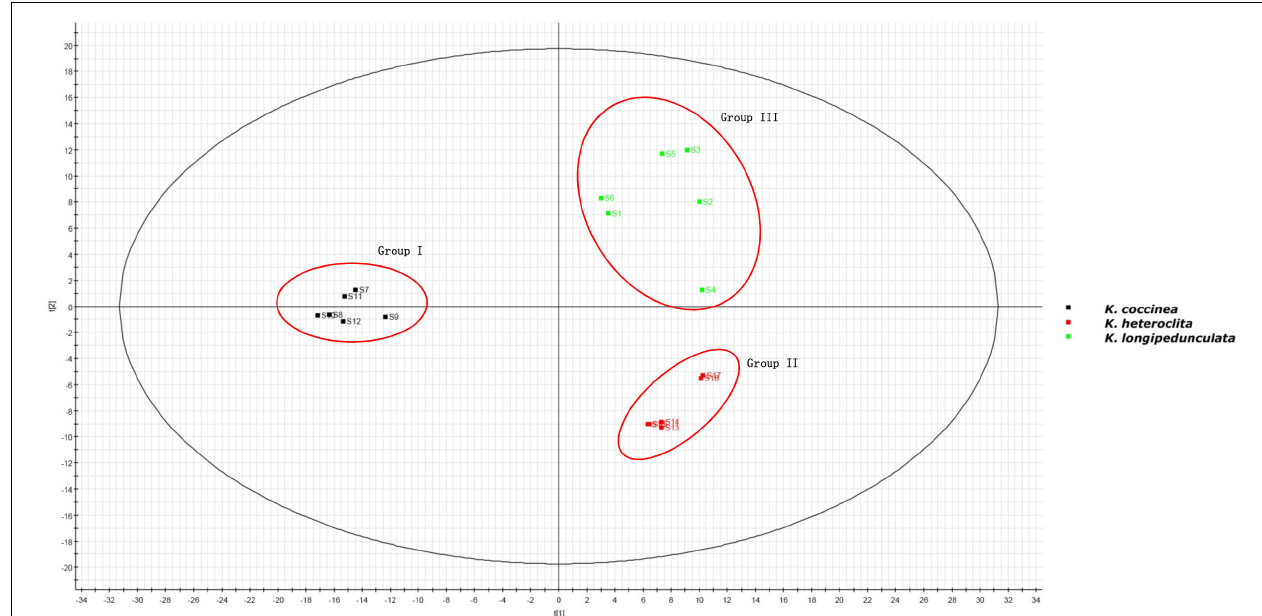
FIGURE 4 | The PCA of K. longipedunculata, K. coccinea and K.